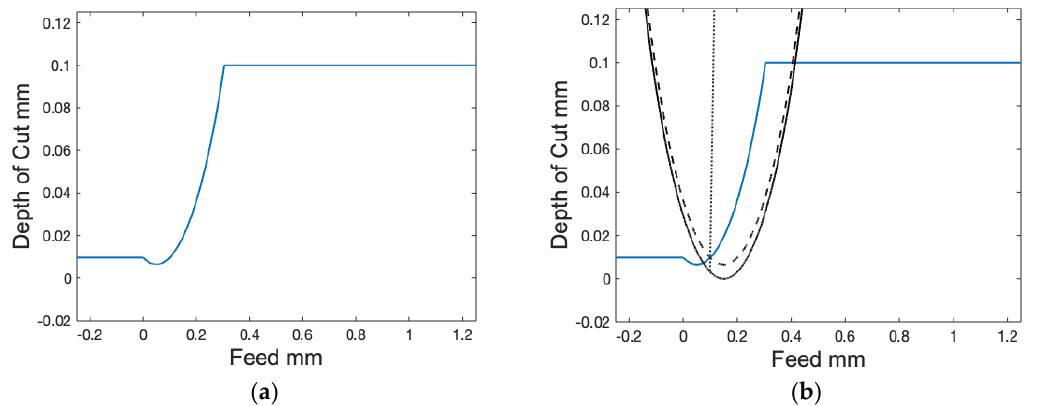
Figure 5. ( a ) Initial model workpiece geometry; ( b ) tool geometry imposed on the previously defined workpiece geometry.